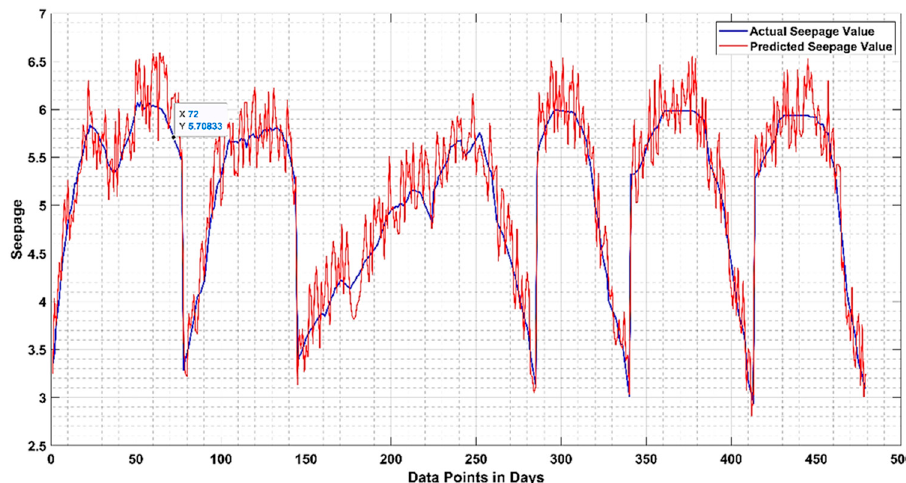
Figure 9. Actual and predicted seepage of Tarbela dam.